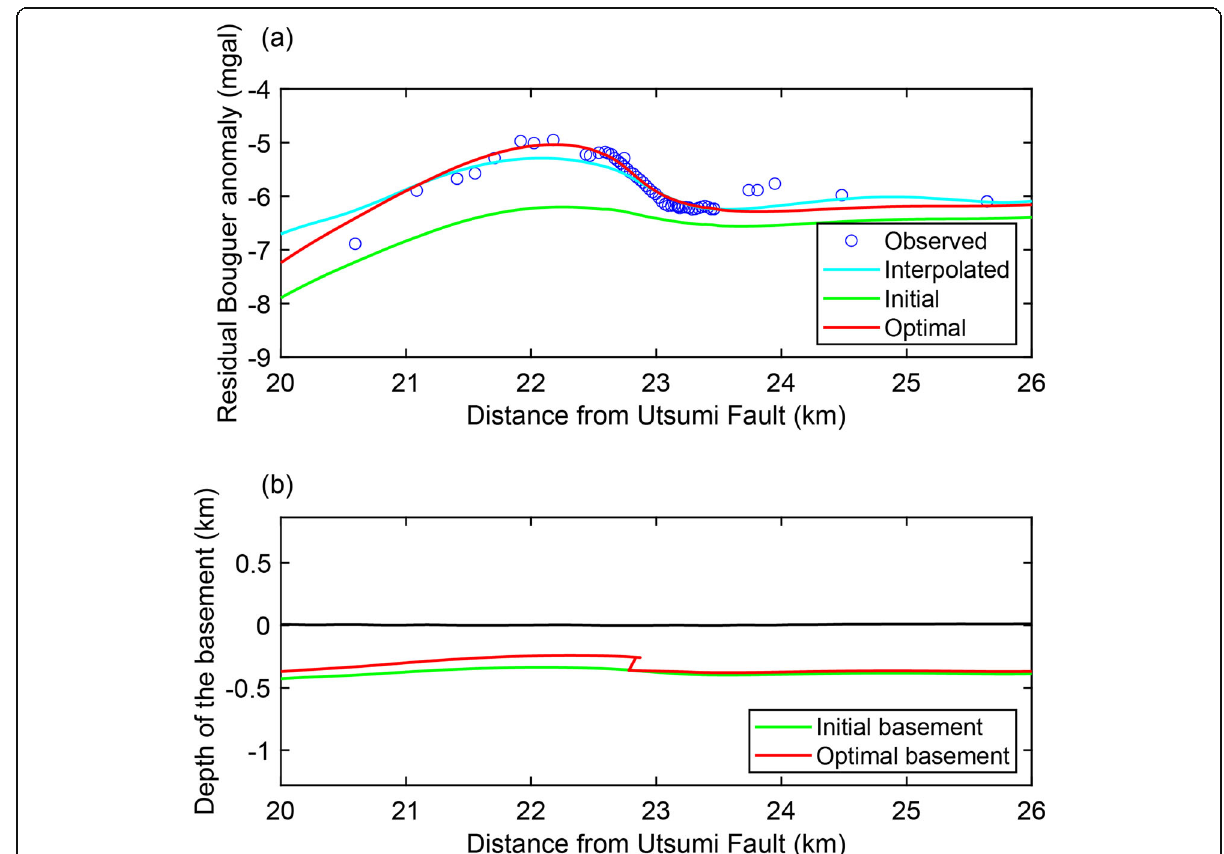
Fig. 9 Close-up views of the profiles of the Bouguer anomaly ( a ) and the topography of the basement surface ( b ) around the Takahama Fault. The tip of the Takahama Fault is located at 22.98 km. a The observed and interpolated residual Bouguer anomalies are represented by open circles and the cyan line, respectively. The interpolated residual Bouguer anomalies come from that of the Fig. 3d. The green line and red line represent the calculated Bouguer anomaly from the initial model (green in b ) and the optimum model (red in b ) using the 2D Talwani ’ s method. b The green line represents the initial model extracted from the gravity basement model (Fig. 7) along the survey line. The red line represents the optimum basement model obtained by selecting the best parameters (Table 2). The black line represents the elevation of the ground surface. The origin of the x-axis is set at the tip of the Utsumi Fault in both a and